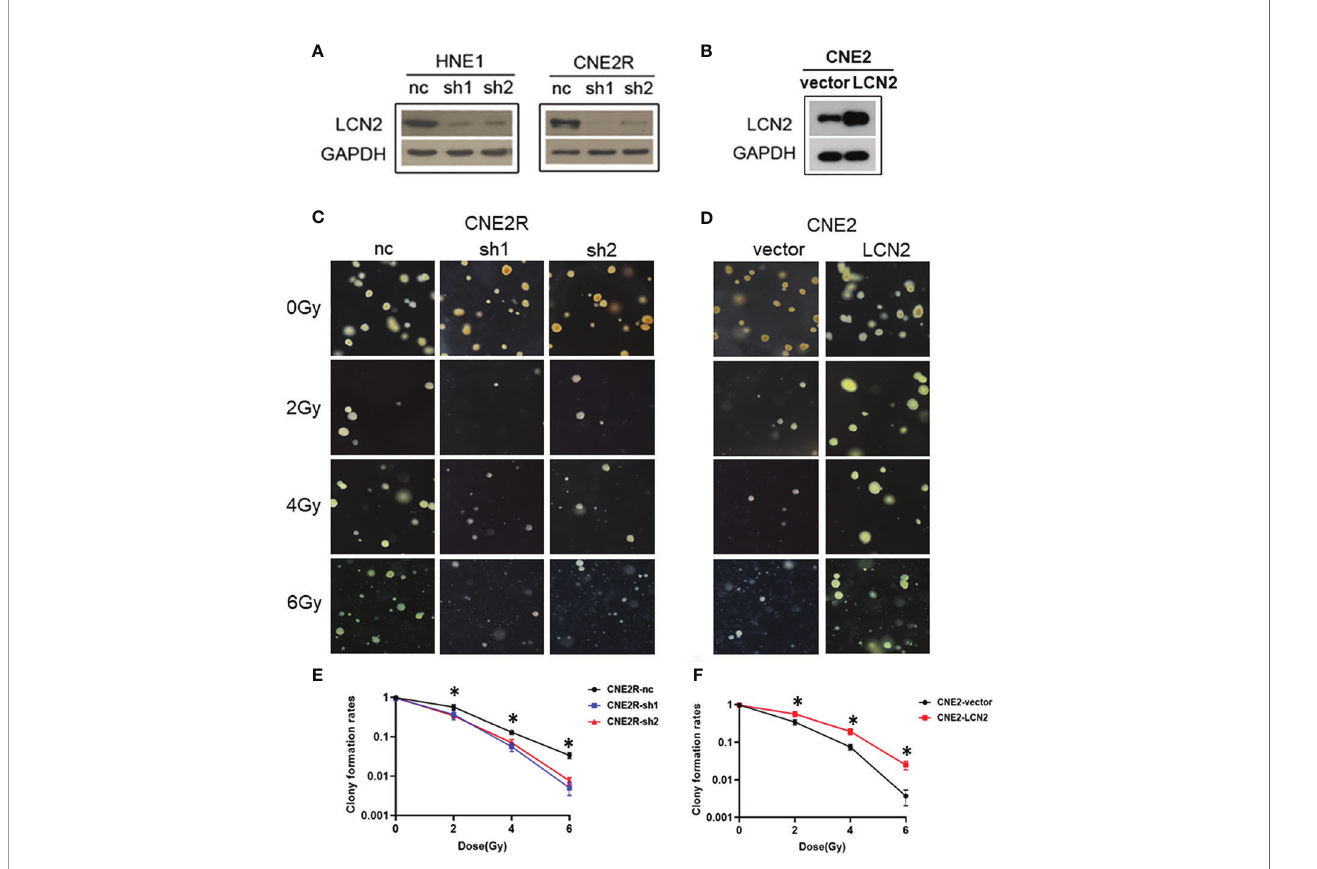
FIGURE 2 | LCN2 regulates the radiosensitivity of nasopharyngeal carcinoma (NPC) cells. (A, B) Validation of LCN2 expression in various NPC cell lines. Knockdown or ectopic expression of LCN2 in HNE1, CNE2R, or CNE2 cells was validated by western blotting. (C, E) A soft agar colony formation assay was used to assess the radiosensitivity of NPC cells. The colony formation rates were markedly reduced in CNE2R cells with LCN2 knockdown compared with that of control cells following irradiation at the dose of 2, 4, or 6 Gy. * P < 0.05. (D, F) CNE2 cells overexpressing LCN2 formed more colonies than control cells at the irradiation doses of 2, 4, and 6 Gy. * P <